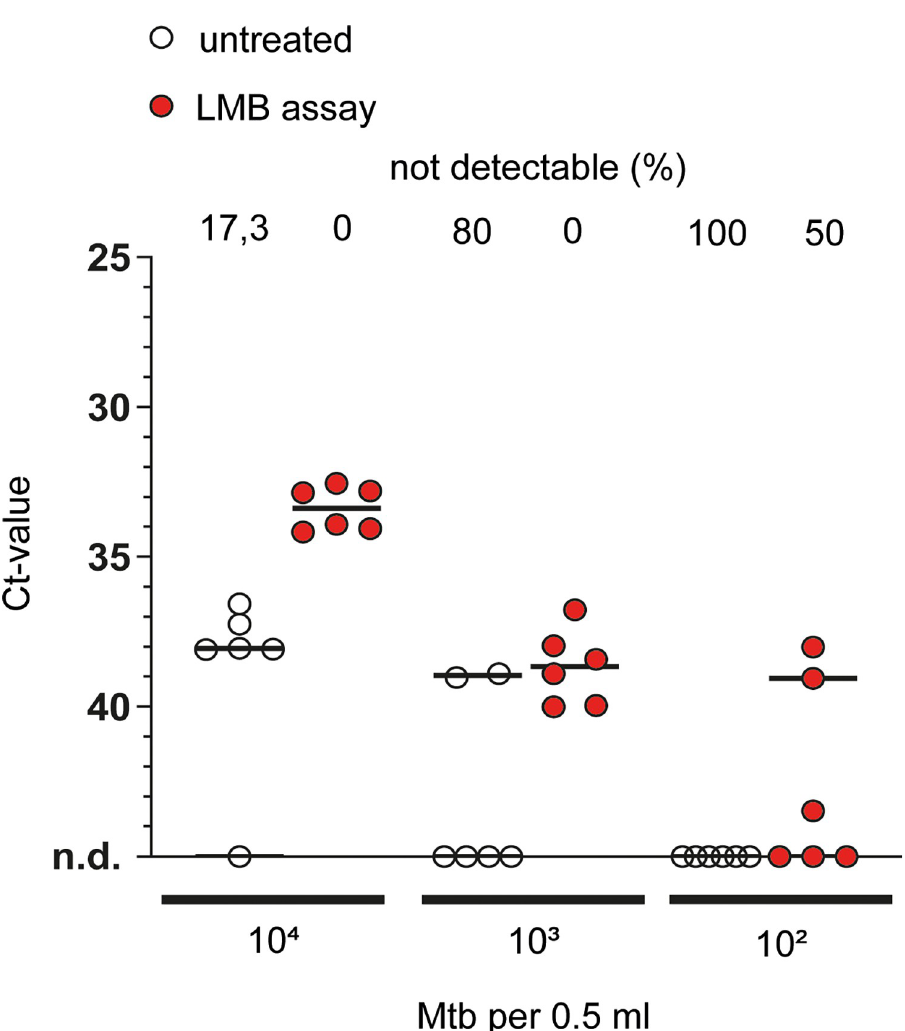
Fig 2. The effect of the LMB-assay on qPCR-based detection of Mtb in buffer. PBS samples were spiked with Mtb H37Rv and either left untreated or underwent pre-treatment with LMBs (LMB assay). The same volume of untreated or LMB pre-treated sample was subjected to heat treatment, DNA purification and qPCR analysis. The horizontal line at each condition depicts the median of data from one representative out of two conducted experiments with six technical replicates. Above each condition, the percentage (%) of samples in which no signal could be detected (not detectable, n.d.) is given. different amounts of Mtb (10 2 –10 5 per 5ml; equivalent of 2x10 1 - 2x10 4 bacteria per ml) and were either left untreated or LMB-assay treated prior to heat-treatment, DNA extraction and qPCR analysis. With 10 5 bacteria, all samples (15 in each group) were tested positive, irrespec- tive of whether the LMB-assay was used or not (Fig 3). Importantly, the mean ct values decreased from 36.99 to 34.5, which represents an enrichment of DNA concentration by per- forming the LMB assay of 4.2-fold, when considering the reaction efficiency of the qPCR (E = 1.77, see S1 Fig). With 10 4 bacteria, Mtb was not detectable in 10 out of 15 (66.6%) of the untreated samples, whereas detection rate remained at 100% with prior LMB-Assay. Similarly, with 10 3 bacteria, Mtb was not detectable in 9 out of 15 (60%) of the cases, while the LMB assay allowed Mtb detection in 93% of the samples. Strikingly, the LMB-Assay allowed the